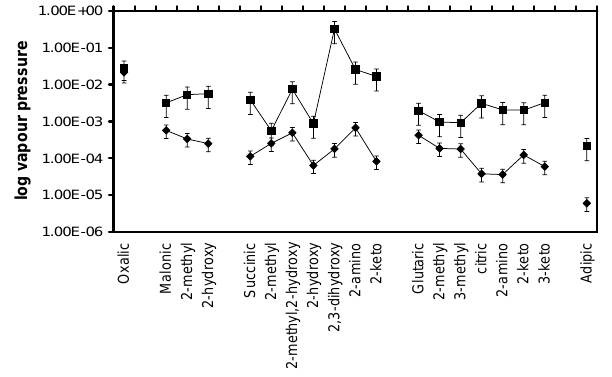
Fig. 2. Vapour pressures in Pa at 298 K. (cid:7) solid state, (cid:4) sub-cooled